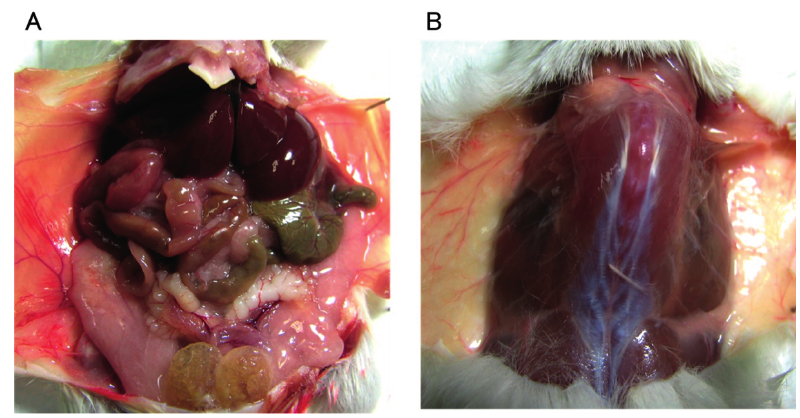
Figure 1. Macroscopic images of the organs in the abdominal cavity ( A ) and subcutaneous tissue ( B ).